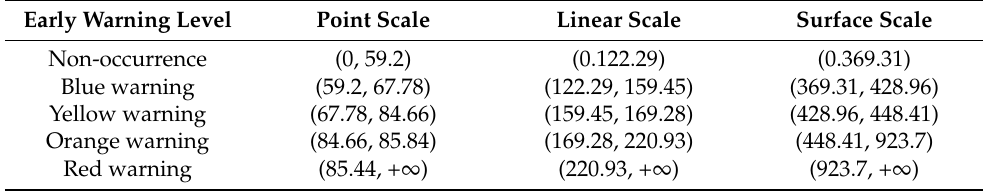
Table 2. The results of deformation threshold intervals with a small scale (mm).